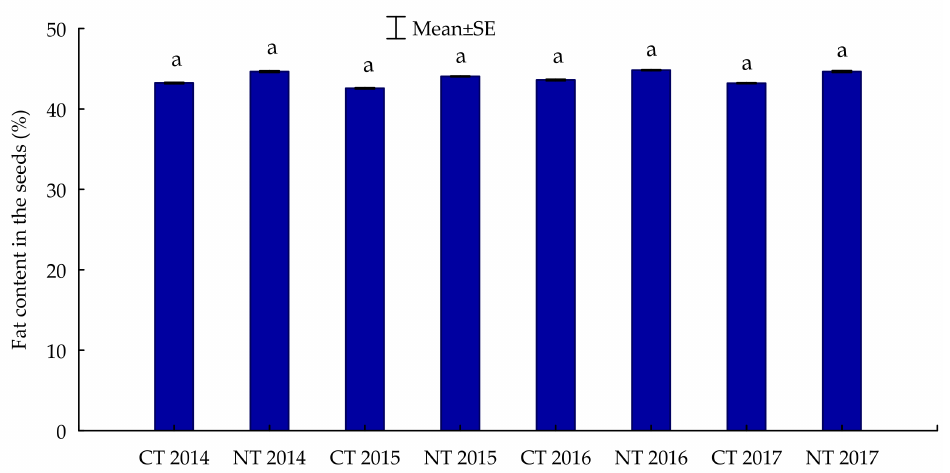
Figure 3. Interactive dependencies of tillage systems and years of research in determining fat content winter oilseed rape seeds. CT—Conventional tillage; NT—No-tillage. The same letter means not significantly different values ( p ≤ 0.05).